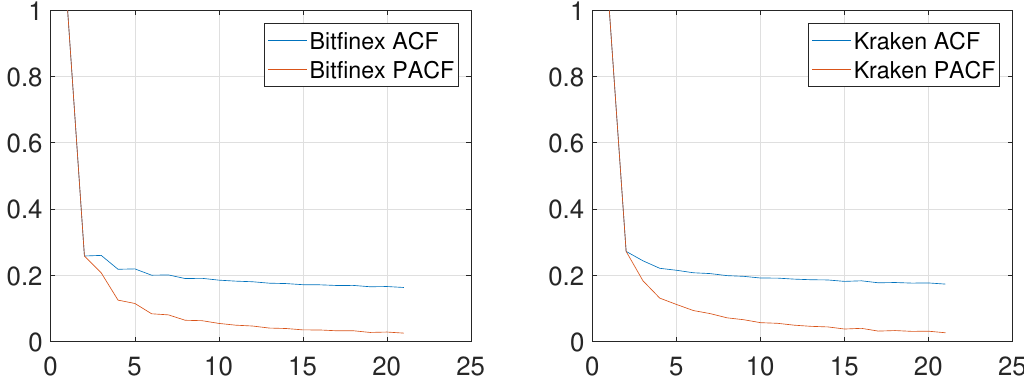
Figure 6. Autocorrelation and Partial Autocorrelation functions. Note. The figure presents the estimated autocorrelation (blue) and partial autocorrelation (red) functions of price durations on Bitfinex (left graph) and Kraken (right